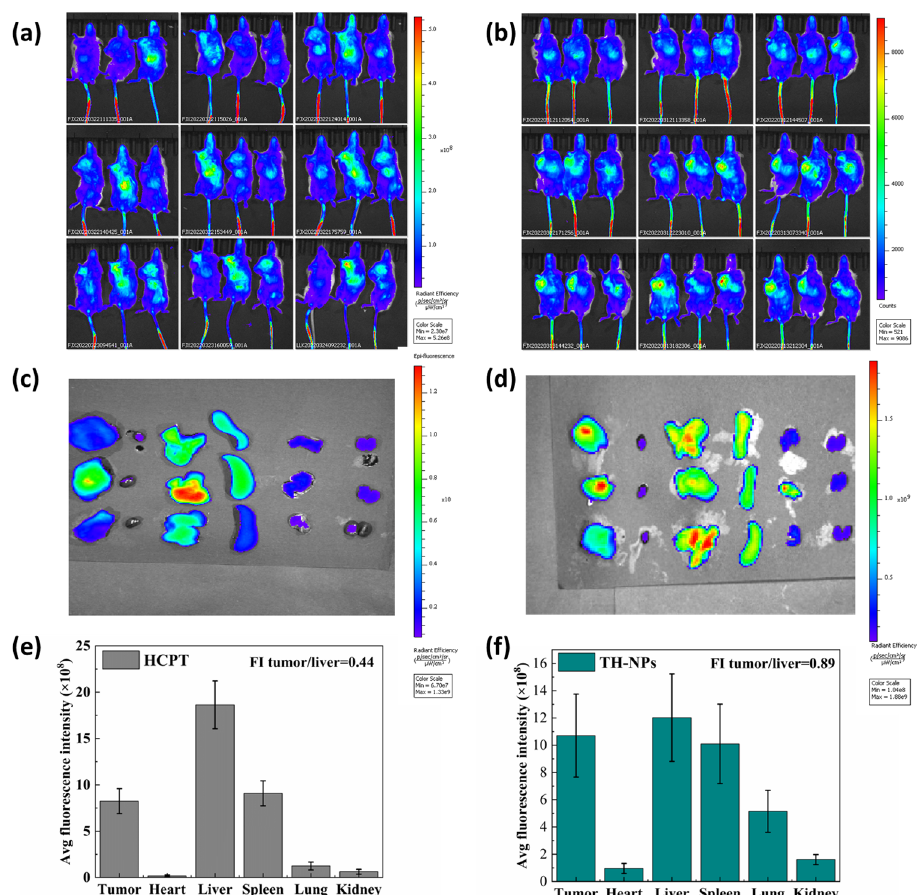
Figure 11. Dynamic biodistribution of DIR-labeled HCPT injection ( a ) and TH-NPs ( b ) in 4T1 tumor- bearing mice (from left to right: 1 h, 2 h, 4 h, 6 h, 8 h, 12 h, 24 h, 36 h, 48 h). The fluorescence image of dissected tumor and major organs (from left to right: tumor, heart, liver, spleen, lung and kidney) from HCPT injections group ( c ) and TH-NPs ( d ) at the end of the 48th hour, and the corresponding fluorescence semi-quantitative analysis (( e ) for HCPT injection, ( f ) for TH-NPs).